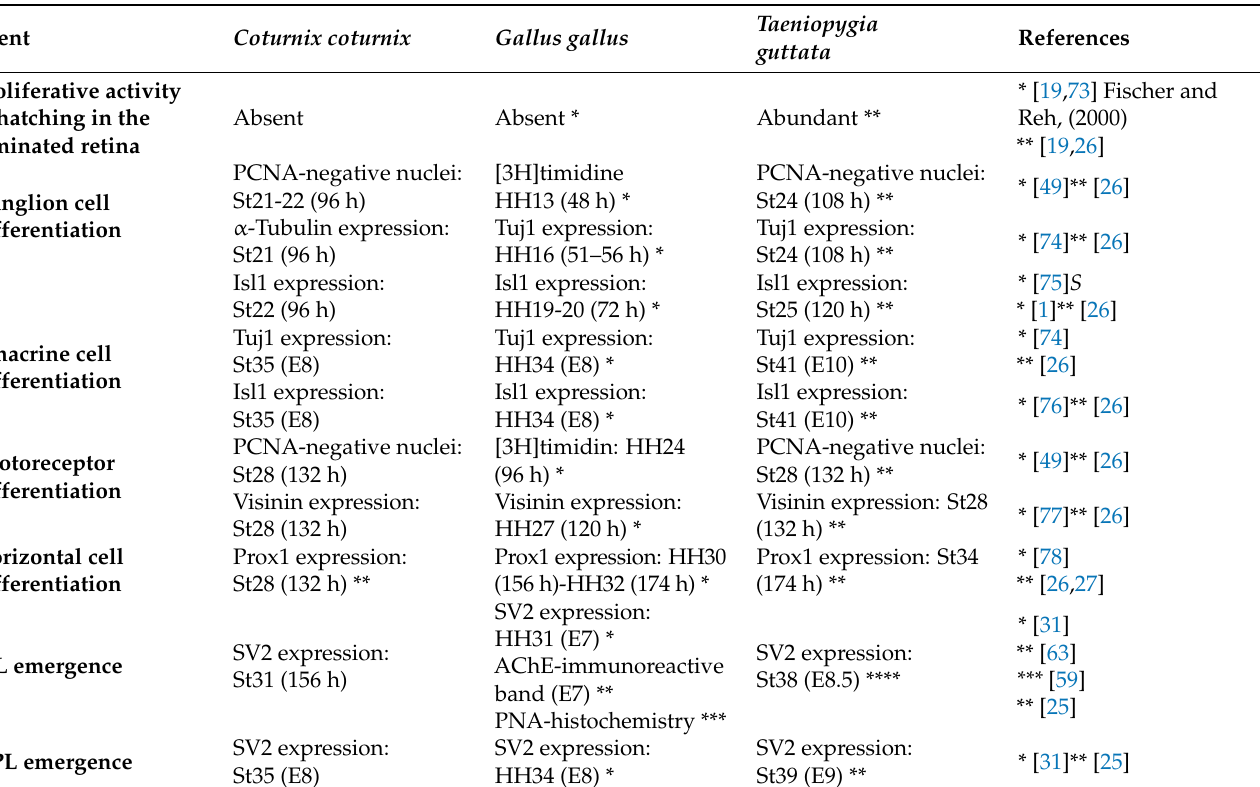
Table 3. Chronology of different features of cell differentiation and histogenesis in the developing and hatched retina of quail, chicken, and zebra finch. HH, stages of Hamburger and Hamilton (1951). Asterisks correlate the results with the publications where they appeared